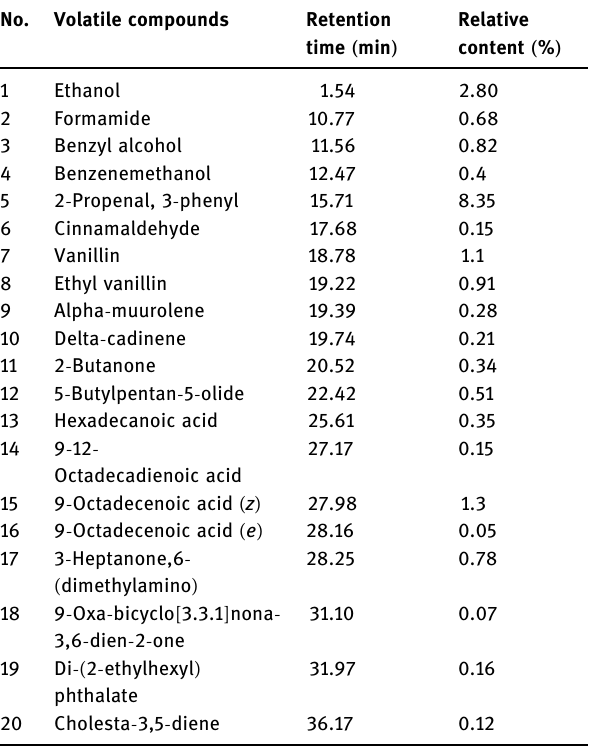
Table 1: Main bioactive compounds of the red pepper extract No. Volatile